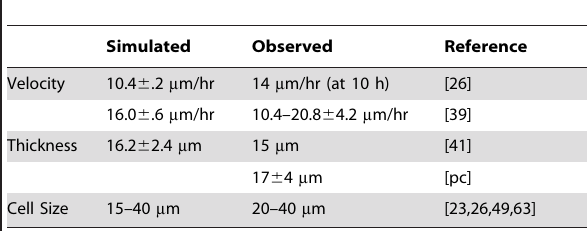
Table 2. A comparison of various morphological measurements for the simulated sprouts showing average velocity, thickness, and cell size compare favorably to experimental